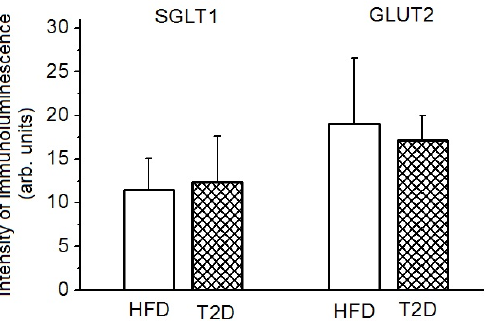
Figure 7. The content of transporters SGLT1 and GLUT2 in the brush border membrane of jejunal enterocytes in the T2D and HFD groups. The T2D group ( n = 4) and the HFD group ( n = 6). Results are expressed as means ± the standard error of the mean (SEM).